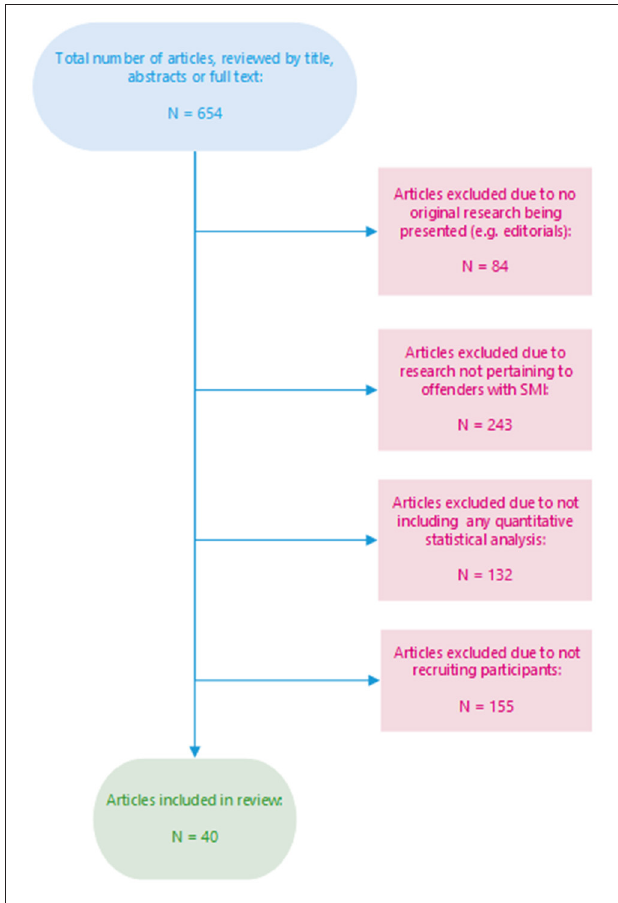
FIGURE 1 | Overview of the article inclusion